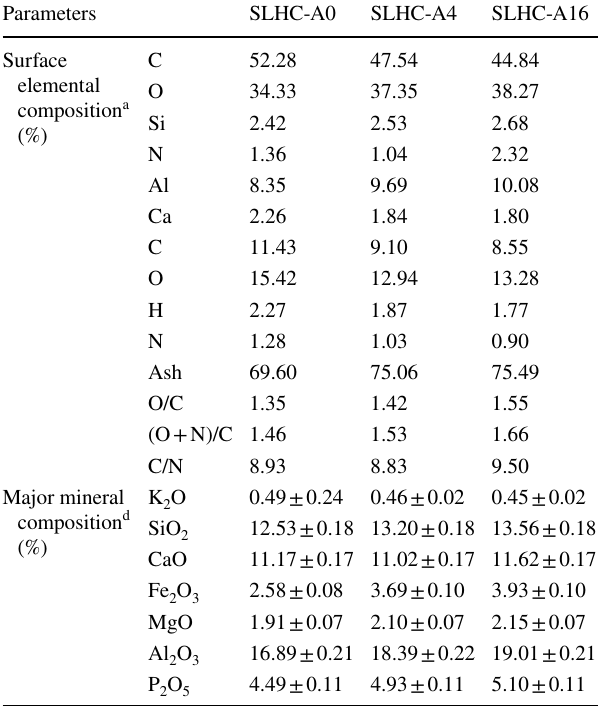
Table 1 Elemental composition, atomic ratio, and major mineral composition of fresh and aged sludge-derived hydrochars